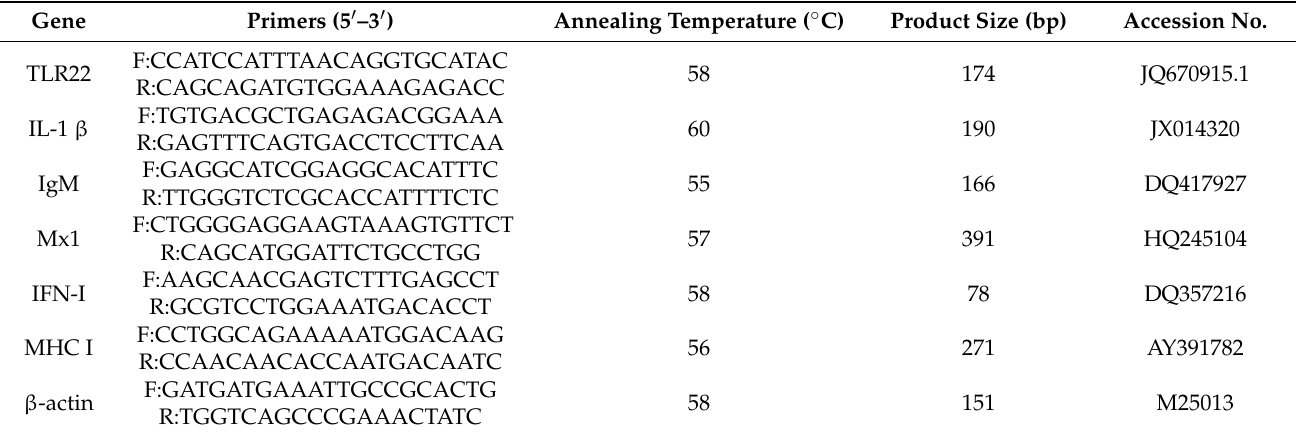
Table 1. Primers used for real-time PCR